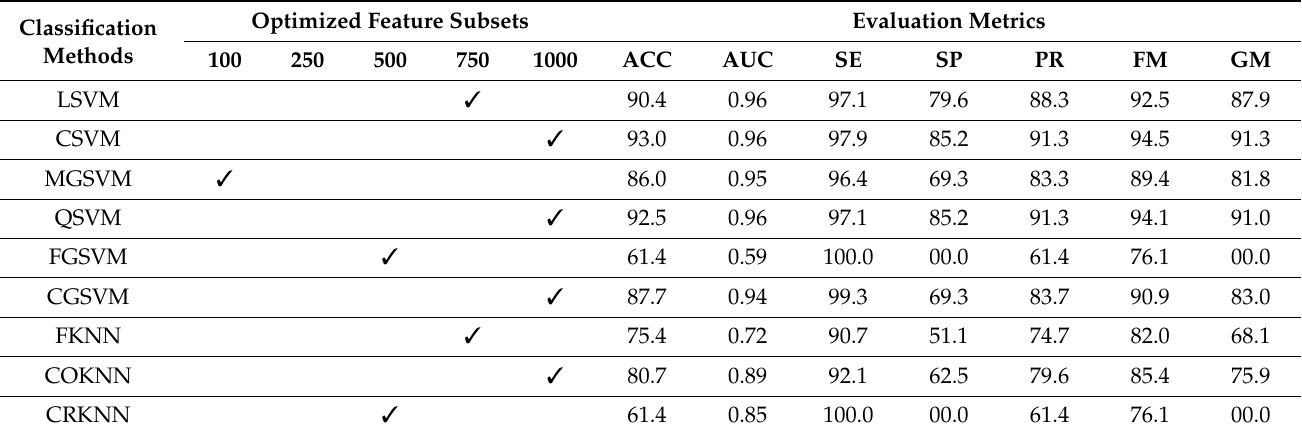
Table 13. Back view-based experimental results on PKU-Reid